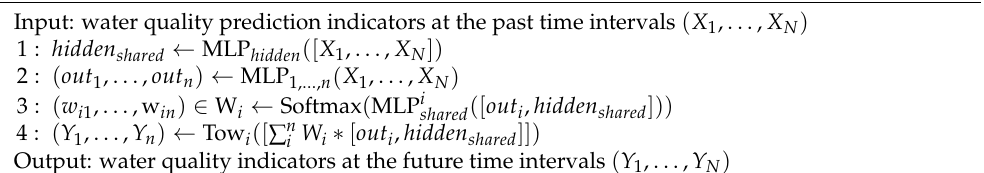
Algorithm 4: Gated Hidden Parameter Sharing Structure Multi-Task Learning for Multi-indicator Water Quality